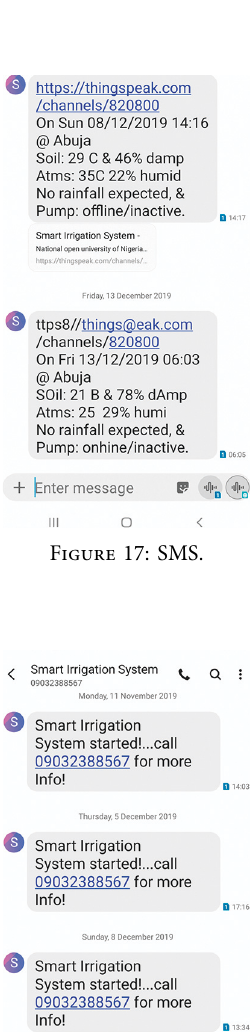
Figure 16: Web interface display.